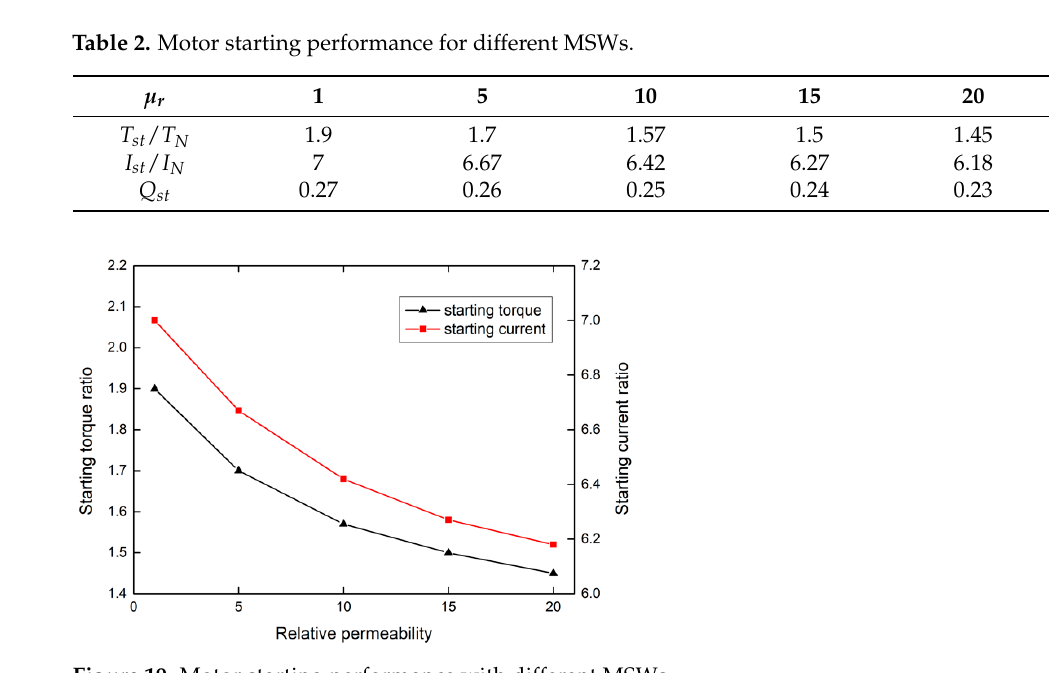
Table 2. Motor starting performance for different MSWs.